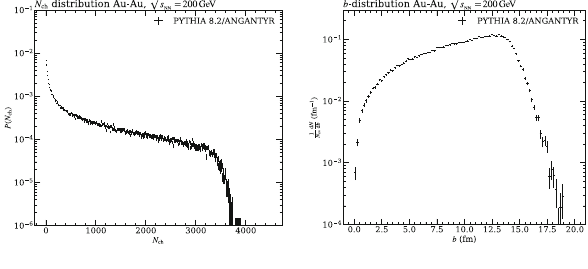
Fig. 5 Centrality observables from the analyses BRAHMS_2004_AUAUCentrality with Pythia 8.2/ Angantyr model [26] displaying the generated calibration curve (left) and the impact parameter calibration curve